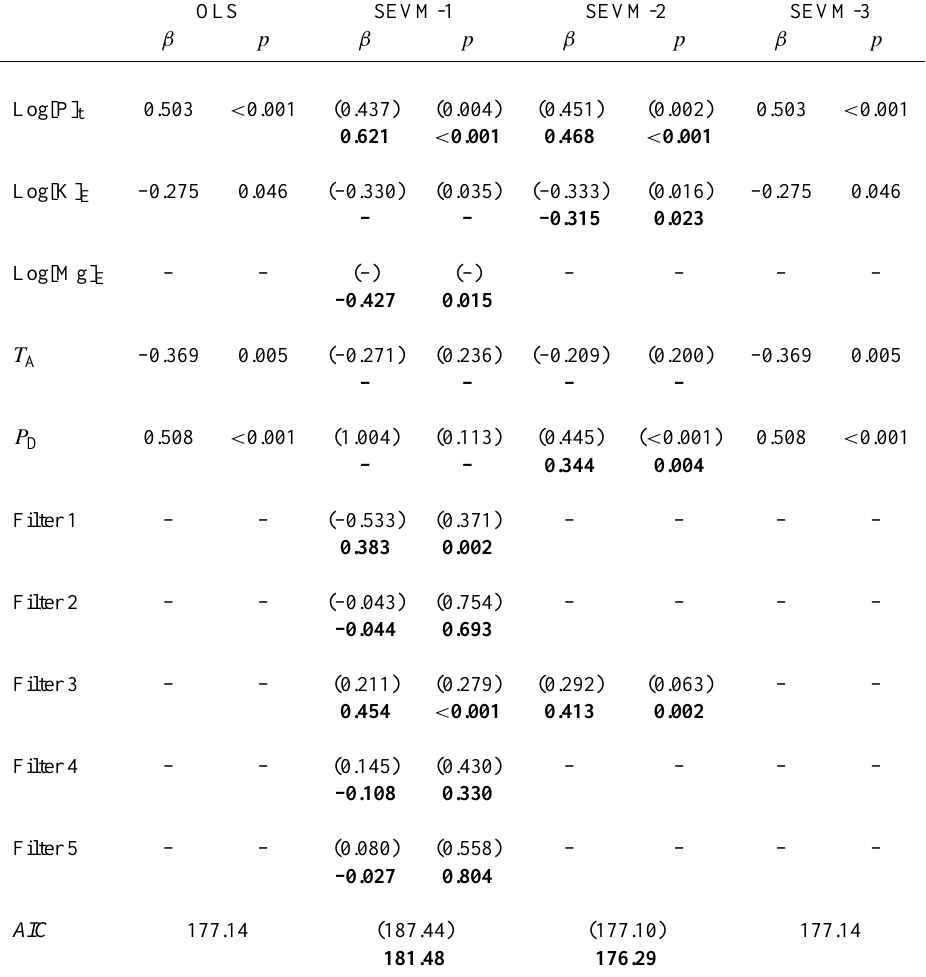
Table 2. Lowest AIC model fits for the prediction of coarse wood productivity with and without the use of spatial filters. For each variable, the upper line gives first the standardised coefficients ( β ) and their level of significance ( p ) from the best OLS model fit followed by (in brackets) the results when the same OLS model is applied with the preselected spatial filter included. Also shown in bold (second line) for each variable are the values of β and p obtained for the lowest AIC model fit with the spatial filters included. Variables not included in any given model fit are denoted with a “–”. Variables: [P] t ; total soil phosphorus: [K] E ; exchangeable soil potassium: [Mg] E ; exchangeable